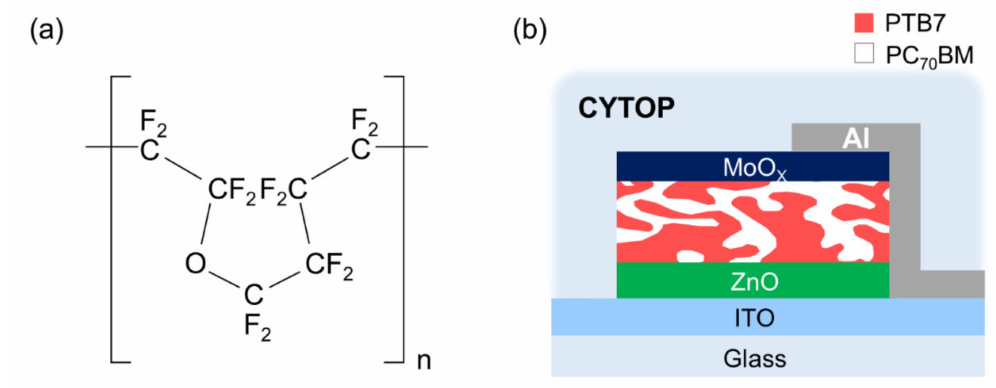
Figure 1. ( a ) Chemical structure of CYTOP and ( b ) schematic illustration of CYTOP-encapsulated organic solar cell (OSC).